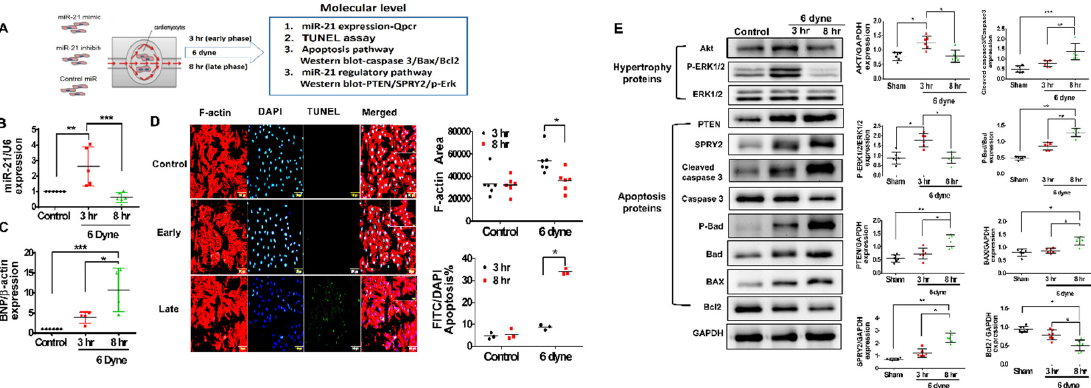
Figure 5. Flow-mediated shear stress triggers a biphasic expression of MiR-21 and is associated with early hypertrophy and later apoptosis-associated protein expressions in cardiomyocytes. ( A ) Schematic diagram of flow mediated shear stress at the early (3 h) and late (8 h) phases at 6 dyne in cardiomyocytes. The relative expression of ( B ) miR-21 and ( C ) B- type Natriuretic Peptide (BNP) was measured by qPCR. ( D ) Immunofluorescence assay of F-actin and terminal deoxynu- cleotidyl transferase–mediated UTP nick-end labeling (TUNEL) analysis were performed to identify cell area and apop- totic cells, respectively. ( E ) Hypertrophy- and apoptosis-associated proteins in cardiomyocytes were measured by western blot. Data are expressed using mean ± standard deviation (S.D.). * p < 0.05, ** p < 0.01, and *** p < 0.001 for difference between each group. (N = 6–8).